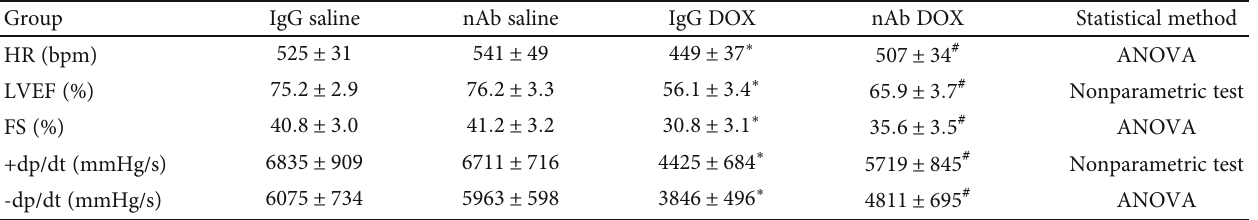
Nonparametric test